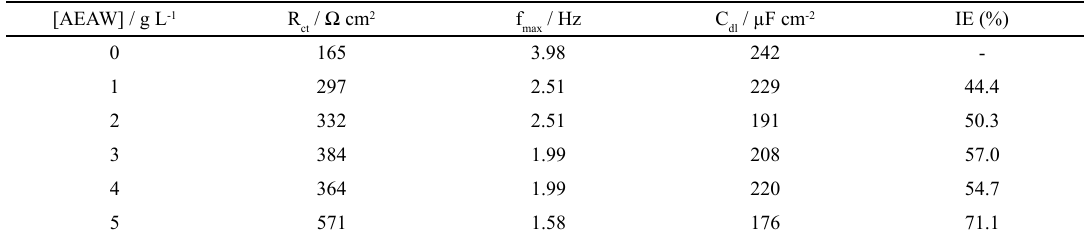
SO obtained by 2 4